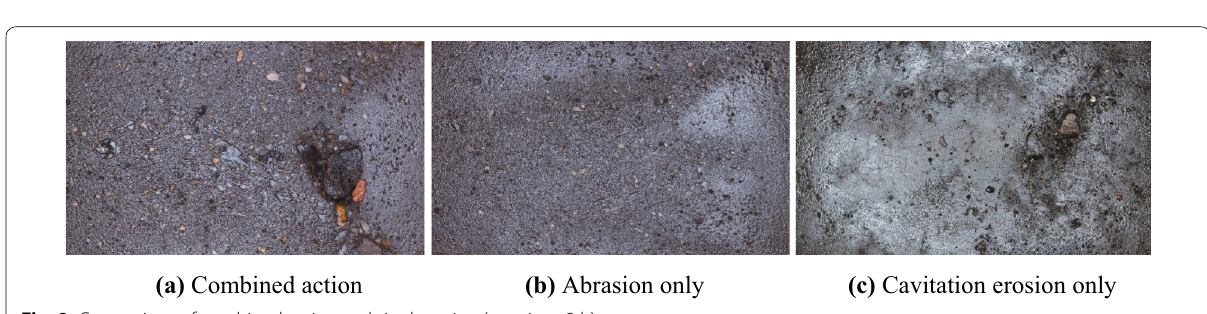
Fig. 8 Comparison of combined action and single action (test time: 3